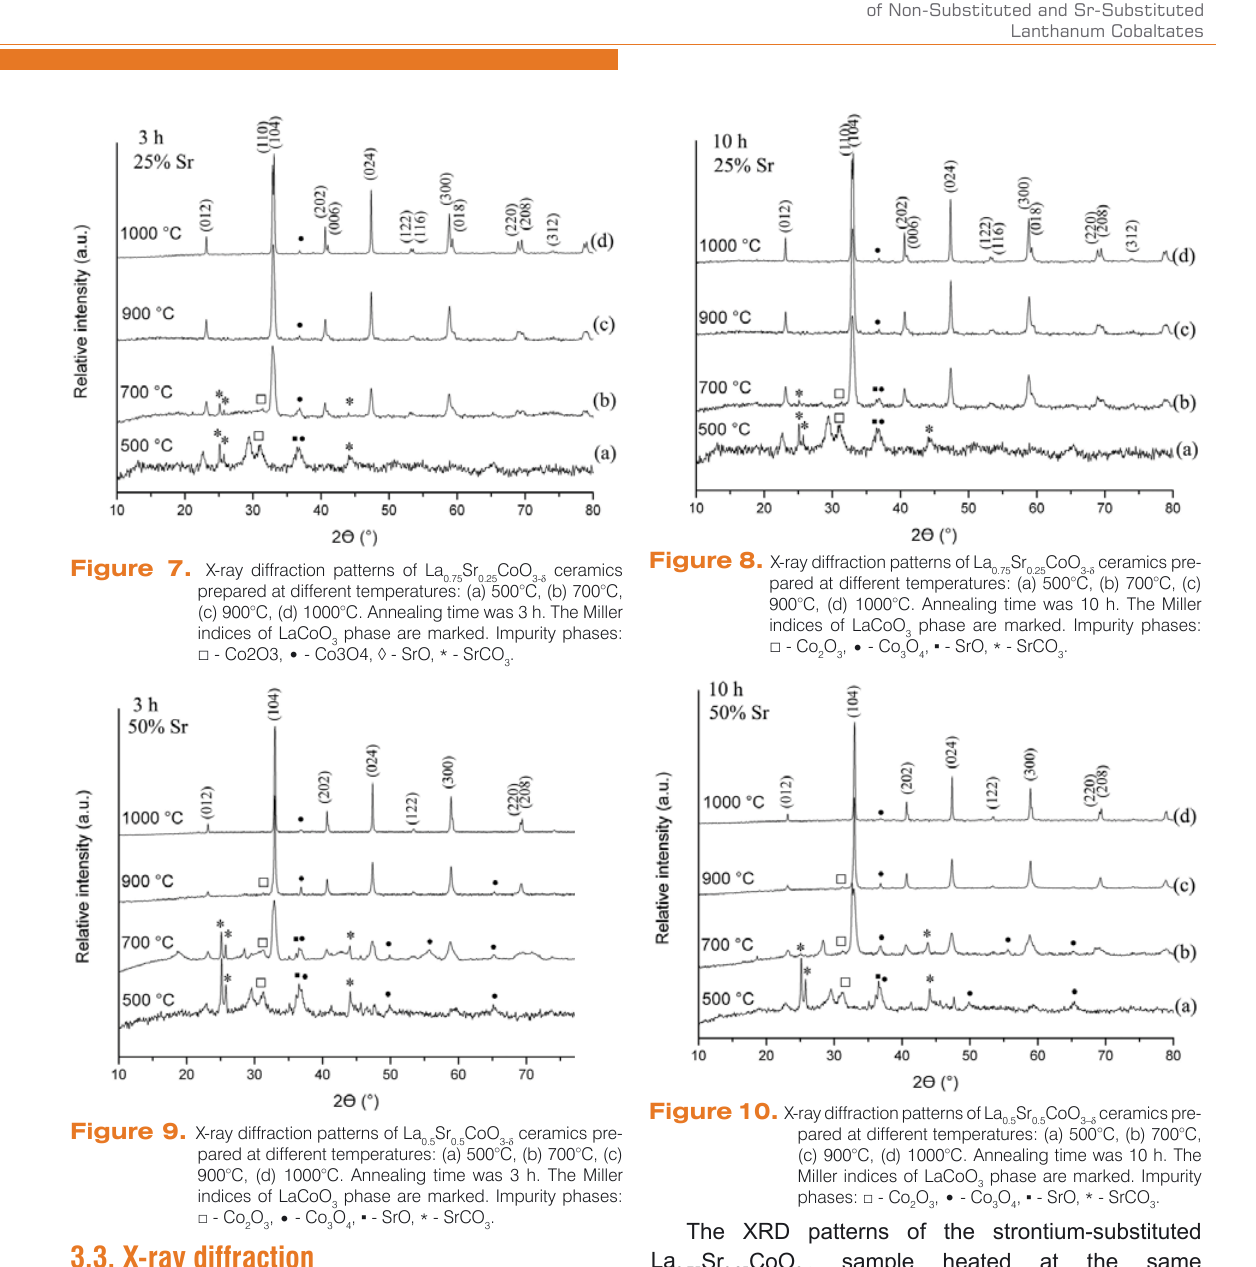
Sr CoO ceramics pre- 0.5 0.5 3- d pared at different temperatures: (a) 500°C, (b) 700°C, (c) 900°C, (d) 1000°C. Annealing time was 3 h. The Miller phase are marked. Impurity phases: indices of LaCoO 3 O , • - Co O , ▪ - SrO, * - SrCO . □ - Co 2 3 3 4 3